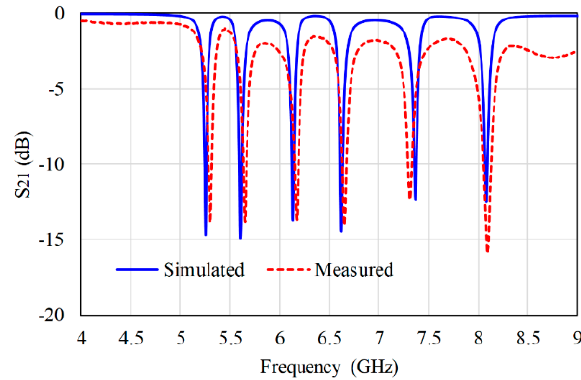
Figure 13. Measured and simulated S 21 for code 010101010101.